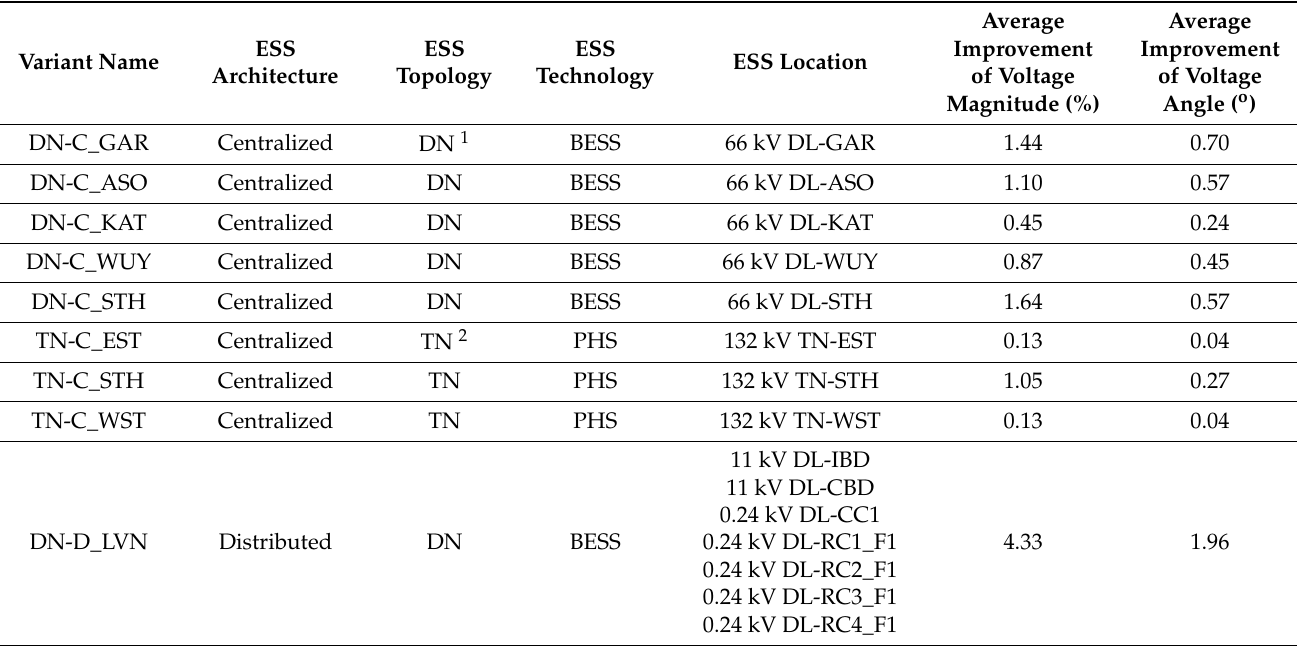
Table 3. Power Quality Performance of the Respective Benchmark Network